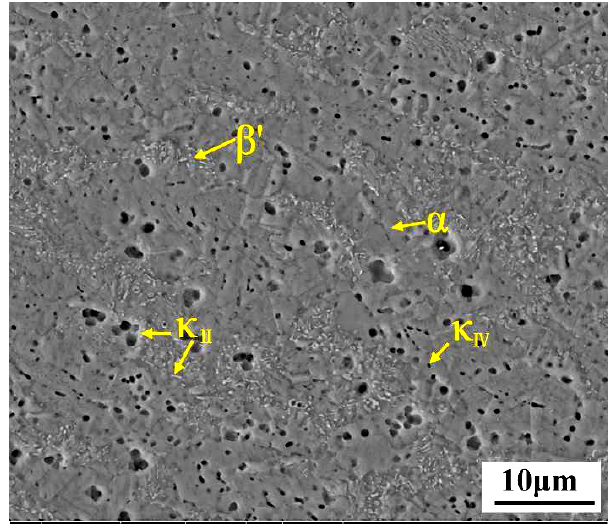
Figure 1. Initial microstructure of forged NAB